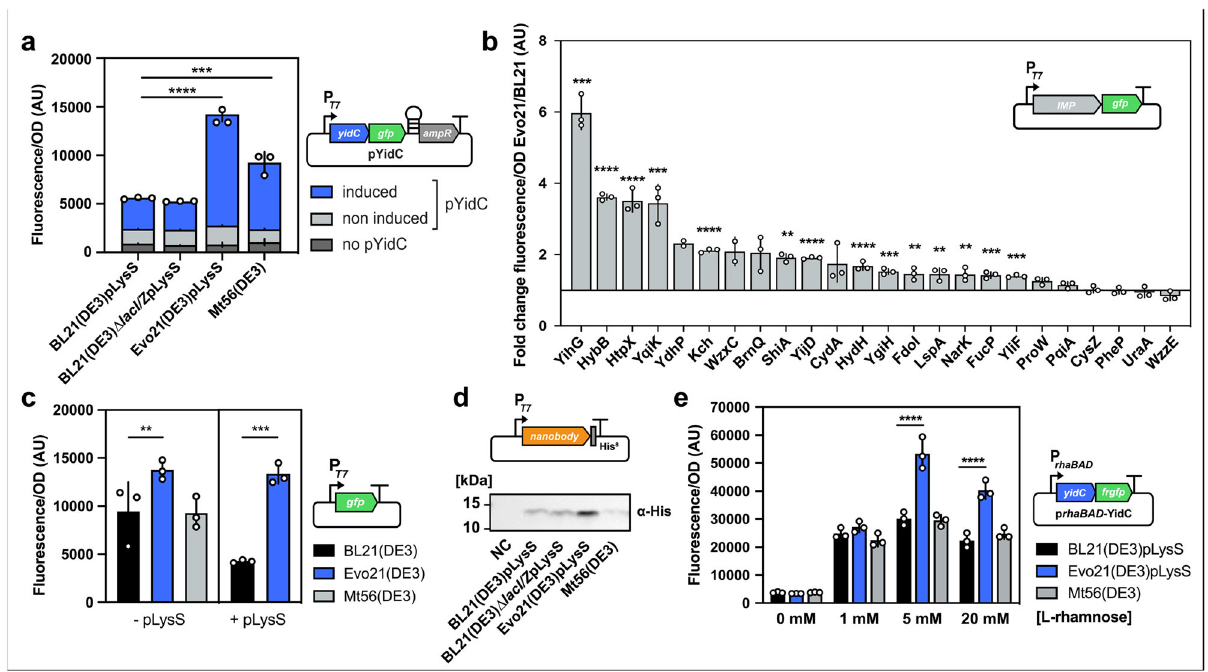
Fig. 2 Characterisation of mutant Evo21(DE3) for toxic and non-toxic protein production. a Production of a toxic YidC-GFP-fusion protein in Evo21(DE3) compared to the non-evolved BL21(DE3) wild-type strain, the BL21(DE3) Δ lacI/Z ancestor strain, and a previously evolved BL21(DE3) derivative Mt56 (DE3). On the illustrated expression vector (pYidC), YidC-GFP production is translationally coupled to ampicillin resistance. b Fluorescence fold change between Evo21(DE3) and BL21(DE3), producing a library of 24 proteins of the E. coli inner membrane proteome C-terminally fused to GFP. c gfp expression levels in Evo21(DE3) and control strains with and without co-expression of the helper plasmid pLysS. d Western blot showing the expression of a camelid- derived single-chain antibody (nanobody) in Evo21(DE3) and control strains. Samples were normalised to cell density before loading. e Production of YidC under the control of a PrhaBAD promoter allowing titration of expression L -rhamnose. All fl uorescence values displayed are normalised to OD at 600nm. Error bars indicated represent the average squared deviation from the mean (SD) of three biologically independent samples ( n =